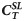
Driving pressure and total pressure dependent outflow as a function of intraocular pressure, for a range of values of α (note: CTSL is 1 microlitre/min/mm Hg).